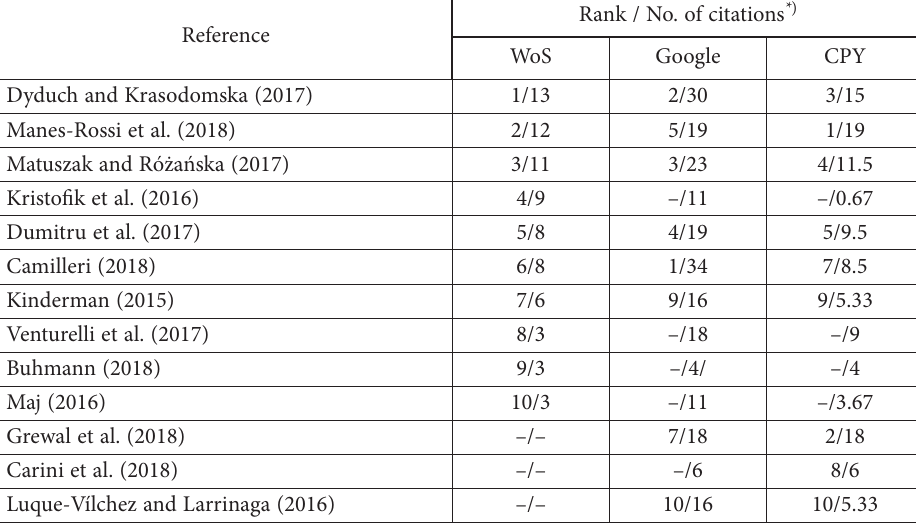
Figure 2. Papers analysis based on the publication year and the number of authors Table 1. Top articles by citations ranking places for tables and